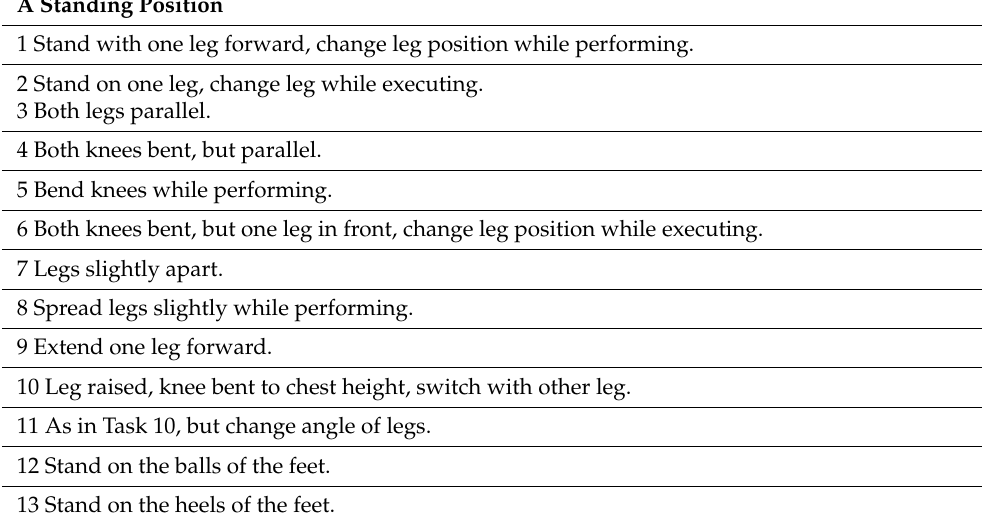
Table A1. Training exercises for the Differential Learning group for the skills underhand pass, overhand pass, and overhand service divided into categories with stronger emphasis on geometry- related (A–D), on velocity-related (E–G), and on mixed (H,I) aspects of